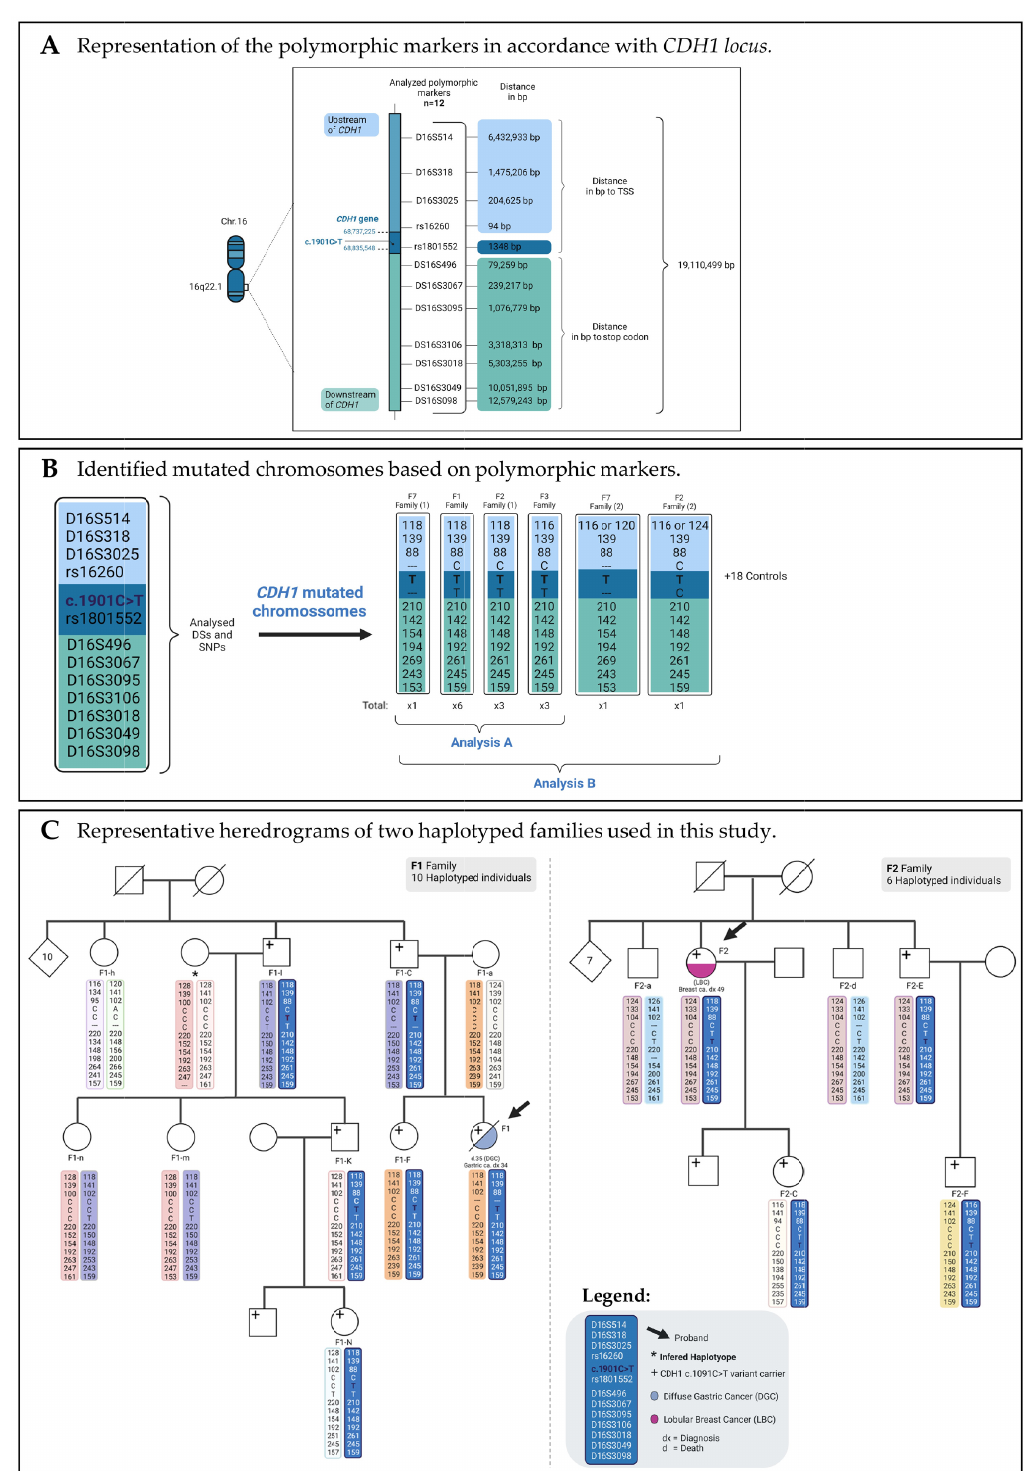
Figure 4. Polymorphic markers used and haplotype results for characterizing c.1901C>T mutated families: ( A ) Represen- tation of the studied polymorphic markers in accordance with CDH1 locus; ( B ) Identified CDH1 mutated chromosomes used in the two different runs performed with DHSMAP for time to most recent common ancestor (TMRCA) estimation; ( C ) Selected heredograms of two representative families used in this study. TSS, transcription start site; bp, base pairs; STRs, short tandem